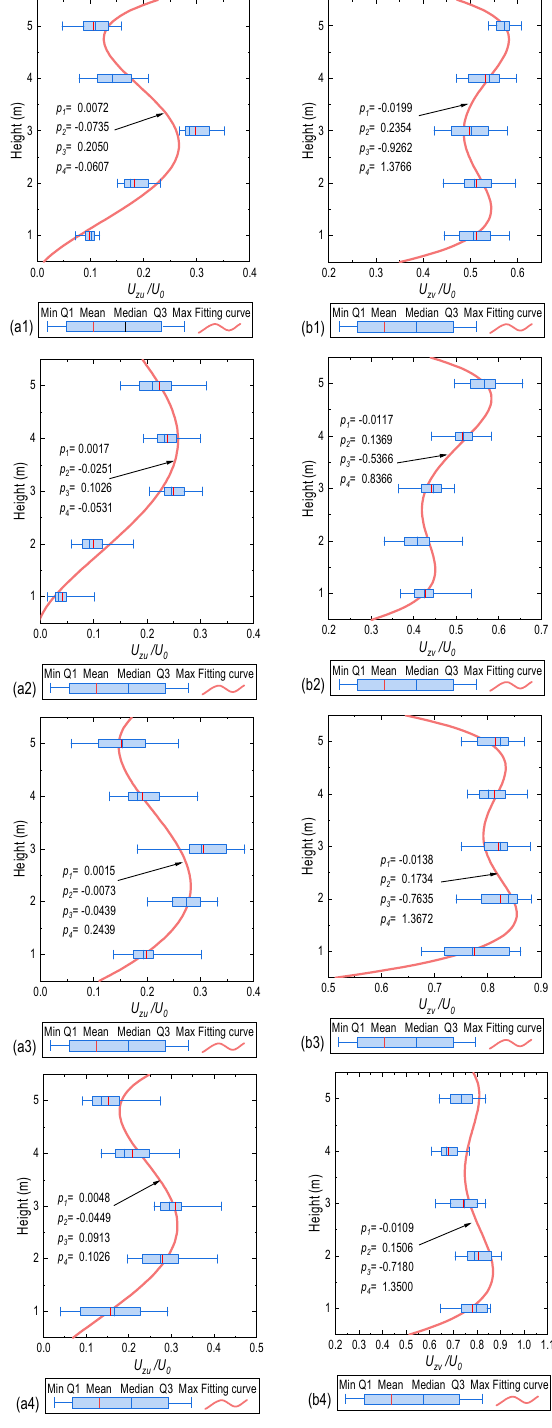
Figure 10. Boxplot of measured wind profile and fitting curve above different lanes: ( a ) lateral wind profile, ( b ) longitudinal wind profile; (1) Lane 1, (2) Lane 2, (3) Lane 3, (4) Lane